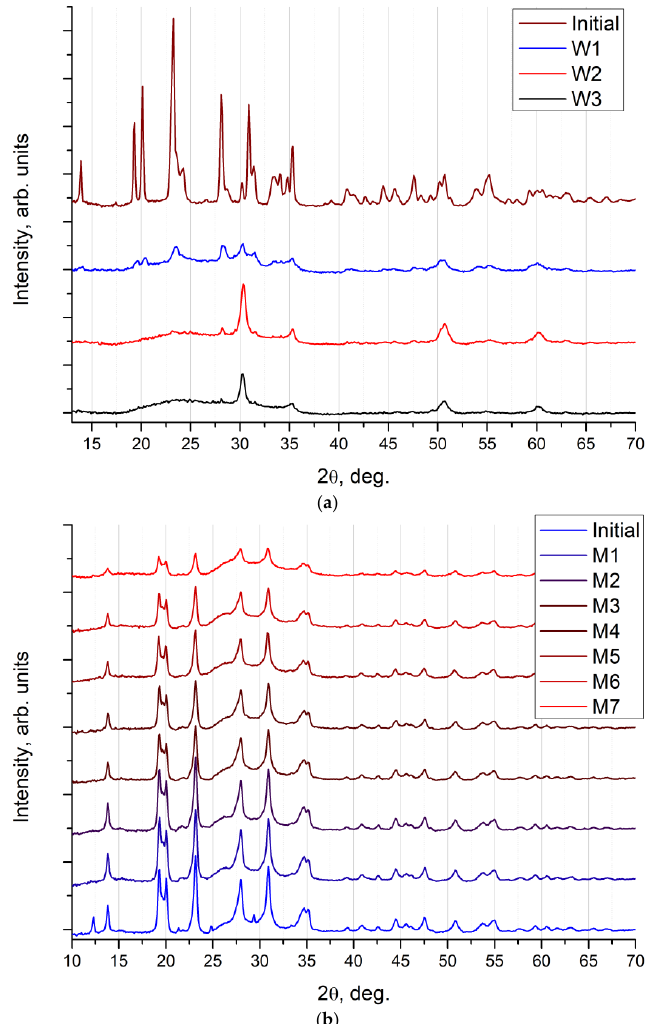
Figure 2. XRD curves of the phosphate tungstates specimens ( a ) and the phosphate molybdates specimens ( b ) with x = 0.5 after irradiation at the following fluences (cm − 2 ). Initial state and when exposed to different Xe ion doses (in cm − 2 ): ( a ): W1 — 3·10 12 ; W2 — 10 13 ; W3 — 3·10 13 ; ( b ): M1 — 10 12 ; M2 – 3·10 12 ; M3 — 6·10 12 ; M4 — 8·10 12 ; M5 — 10 13 ; M6 — 3·10 13 ; M7 — 6·10 13 . As for the Na 0.5 Zr 2 (PO 4 ) 2.5 (MoO 4 ) 0.5 ceramics (Figure 2b), XRD results showed a weak impact of ion irradiation on crystallinity of these ceramics. Diffraction peaks were seen clearly, even at irradiation doses of up to 6·10 13 cm -2 . Changes caused by ion irradiation in this series concerned the coherent scattering region sizes of the Na 0.5 Zr 2 (PO 4 ) 2.5 (MoO 4 ) 0.5 phase slightly. However, ion irradiation did not result in critical degradation of crystallinity, as in the case of the Na 0.5 Zr 2 (PO 4 ) 2.5 (WO 4 ) 0.5 ceramics. Intensity of XRD peaks reduced 4 times with an increase in the irradiation dose of the Na 0.5 Zr 2 (PO 4 ) 2.5 (MoO 4 ) 0.5 ceramics (Figure 2b).